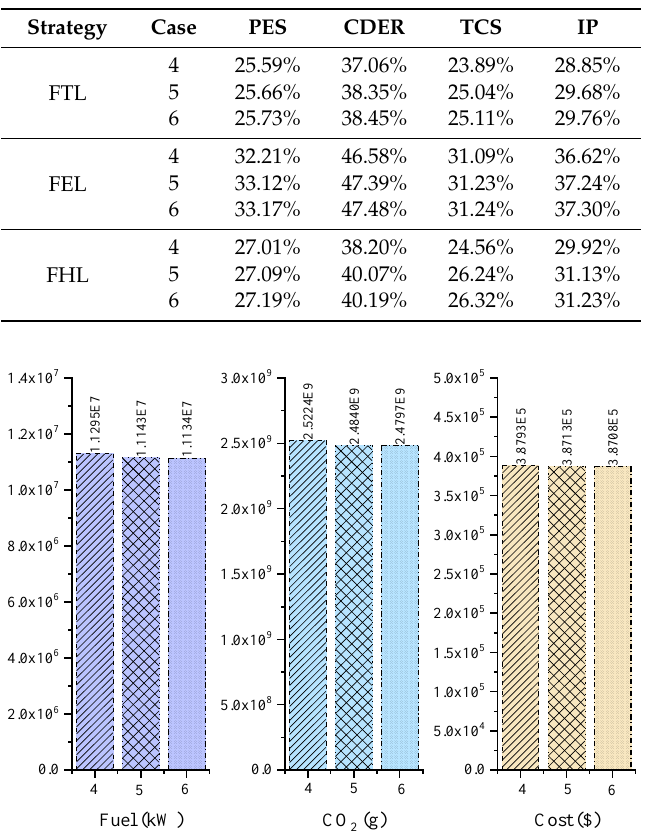
Table 5. System performances of uncertain cases.